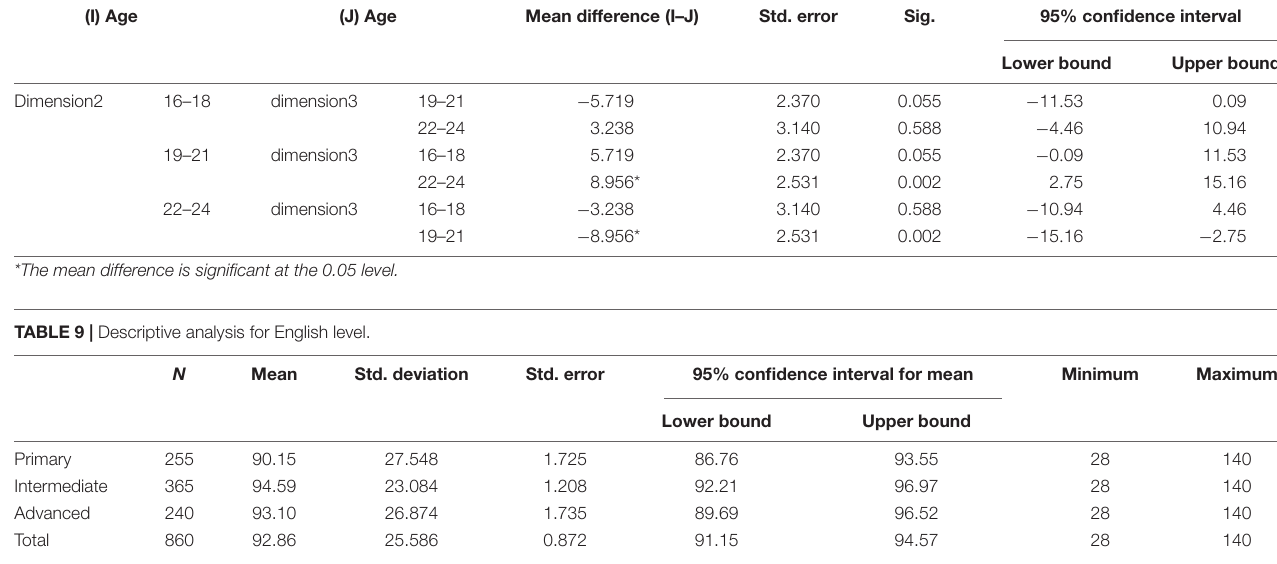
TABLE 8 | The results of Scheffe test of multiple comparisons for age. (I) Age (J) Age Mean difference (I–J)